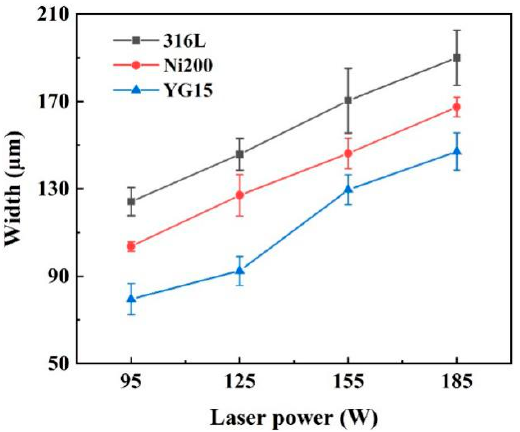
Figure 5. Widths of the single tracks formed at different laser powers.